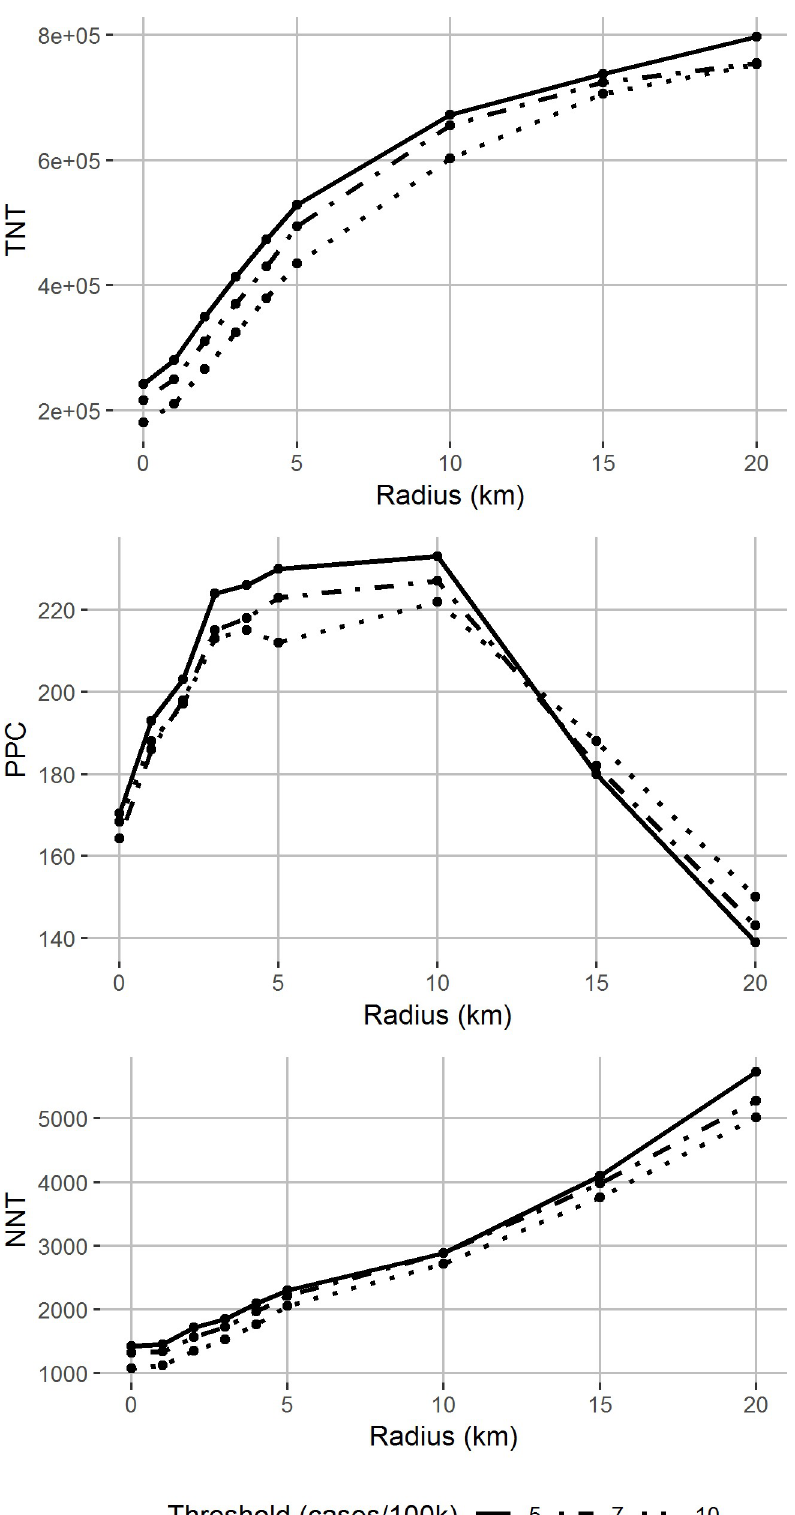
Fig 4. Potential effectiveness and efficiency of prophylaxis strategies by radius of prophylaxis. Total number treated, potentially prevented cases (PPC) and number needed to treat per PPC by radius of prophylaxis, varying the health area-level threshold for intervention start (line